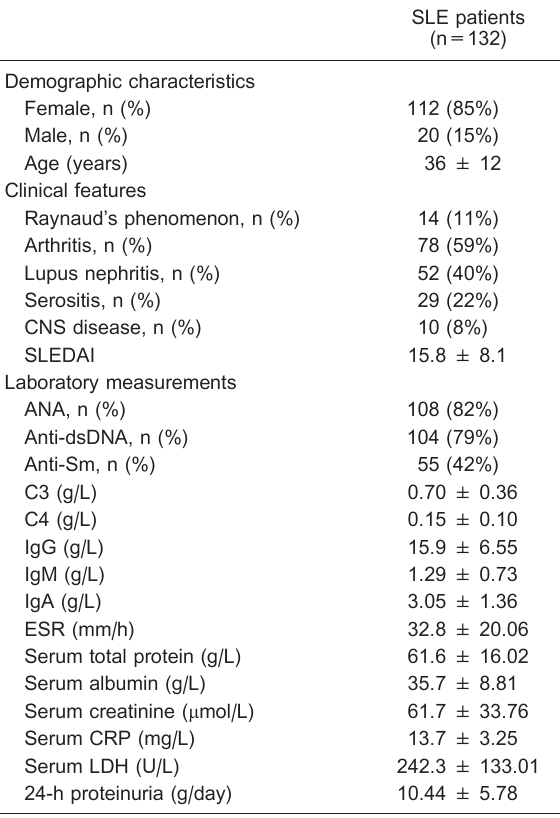
Table 1. Demographic characteristics, clinical features and laboratory measurements of systemic lupus erythematosus (SLE)